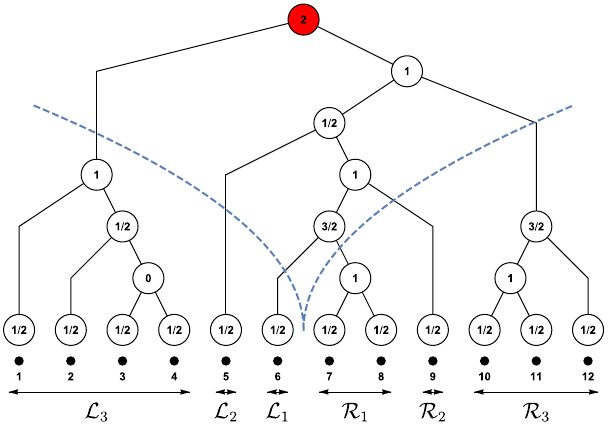
FIG. 20. Tree state generated by the SDRG and its entangle- ment properties. A Schmidt cut at the middle of the system gives rise to a cut of the tree into a forest and prescribes a view of the chain as a collection of clusters lying to the left ( L right ( R ) of the cut. With the full chain in the quantum state i described by the tree, each cluster has the projection of the total momentum as the only